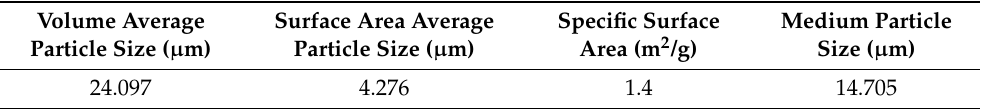
Table 3. Particle size analysis results of phosphorus tailing micro-powder.